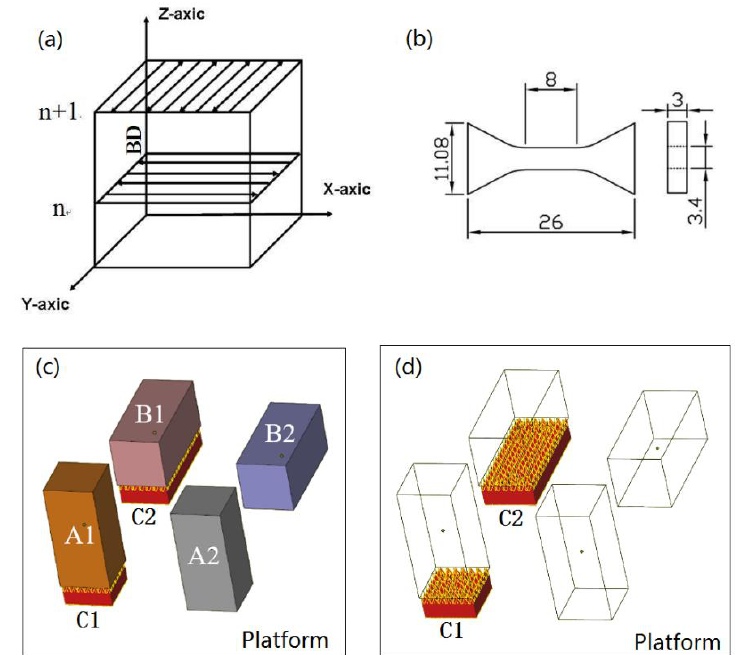
Figure 2. ( a ) Schematic diagram of scanning strategy. ( b ) The test sample schematic after machining from middle part of the SLM sample; the units are mm. ( c ) The orientation of the building specimens, A1 is the vertical sample with support and A2 is without support, B1 is the horizontal sample with support and B2 is without support. The size of A1, A2, B1 and B2 is 12 × 12 × 30 mm. ( d ) C1 and C2 are supports under A1 and B1. The height of C1 and C2 is 3 mm. Table 2. The manufacturing parameters of SLM used in this study.